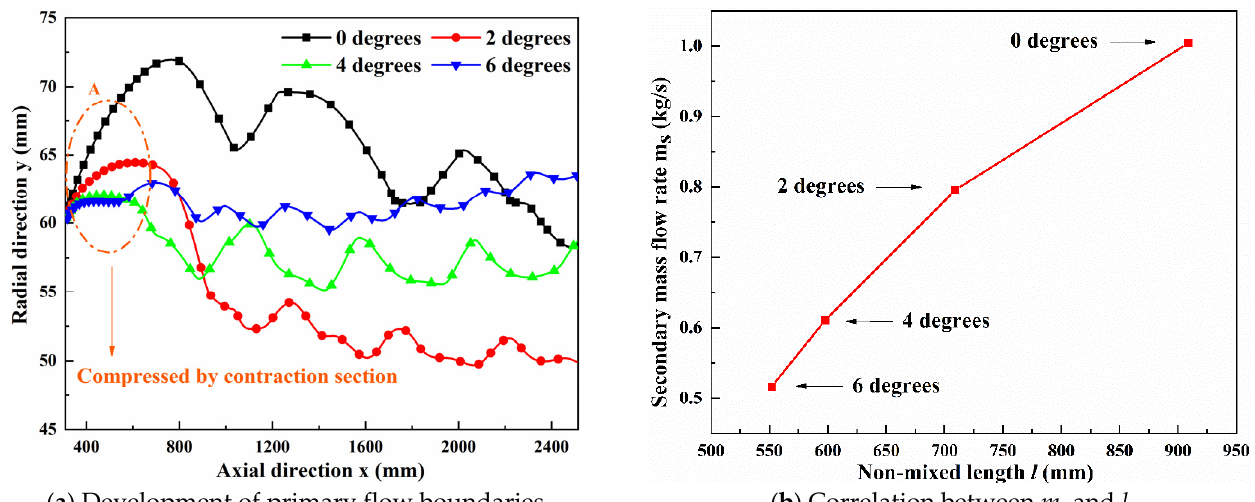
Figure 10. Contraction angle ( ϕ ) of different mixing chambers: ( a ) development of the primary flow boundary from the nozzle exit to the outside; ( b ) the relationship between m s and the non- mixed length l (region A is the area where the primary flow boundary is compressed by the contraction section).